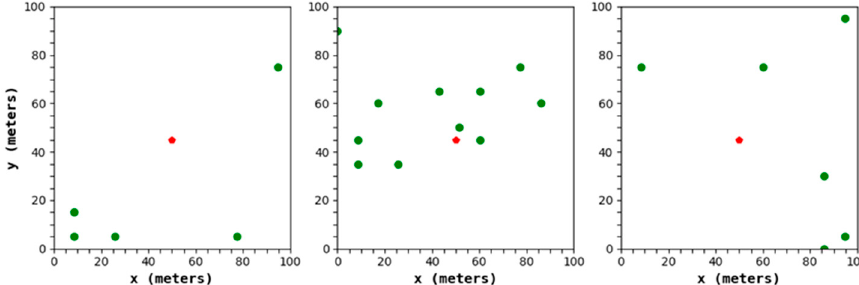
Figure 7. The three rounds of uneven CH distributions generated by the LEACH (Low-Energy Adaptive Cluster Hierarchical)